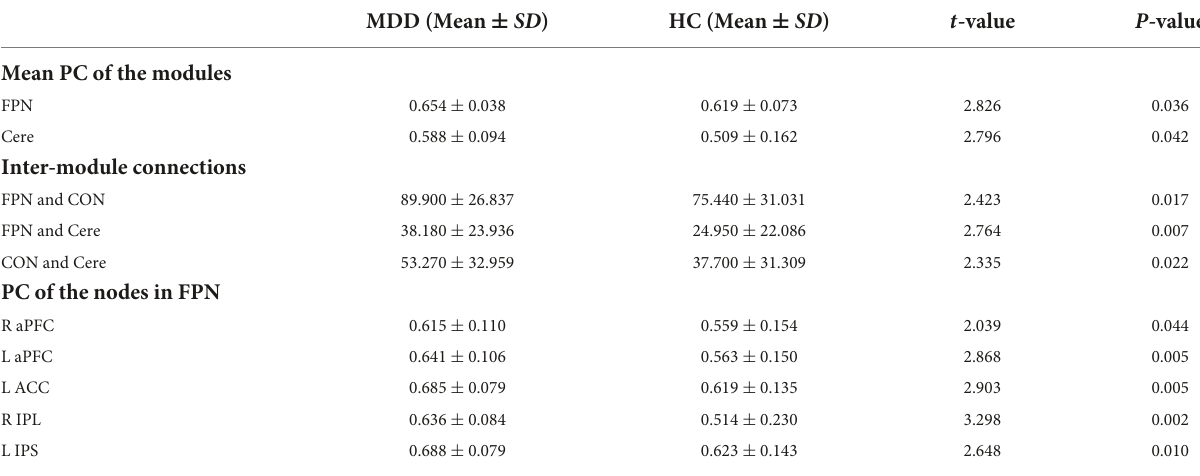
TABLE 2 Significant differences in the mean PC of modules, the inter-module connections and the PC of